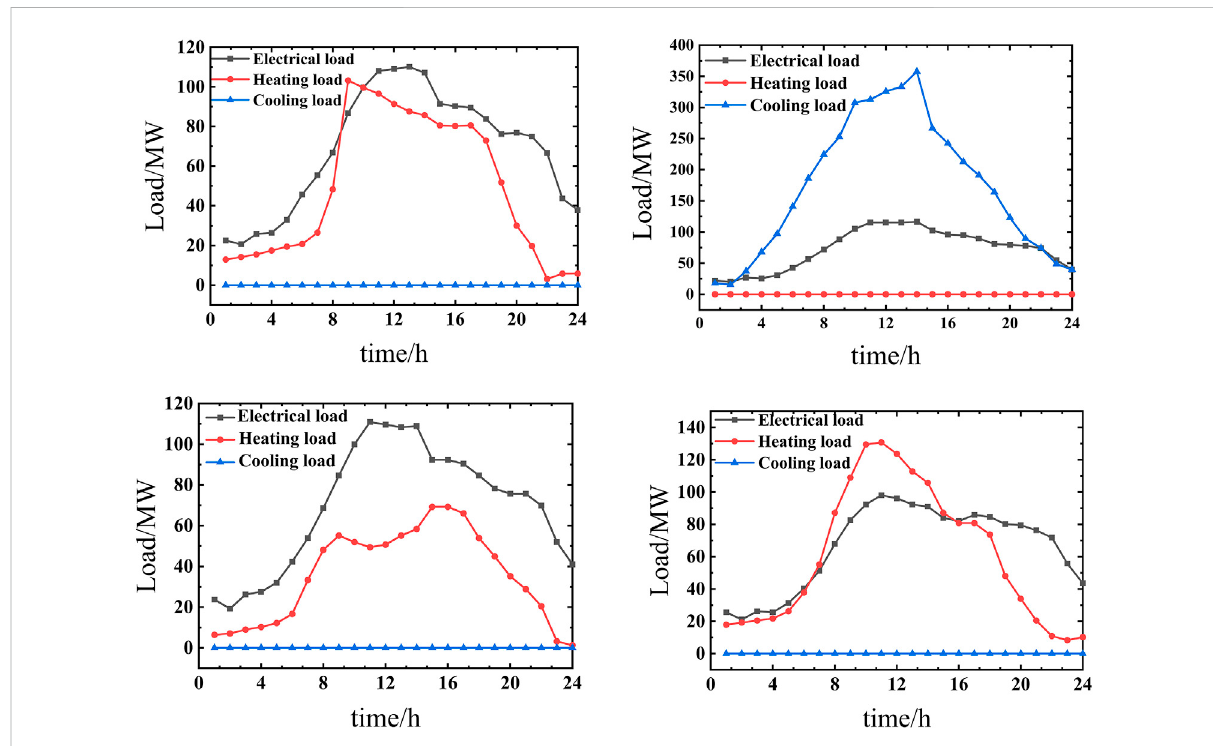
FIGURE 4 Load curves of four typical days.